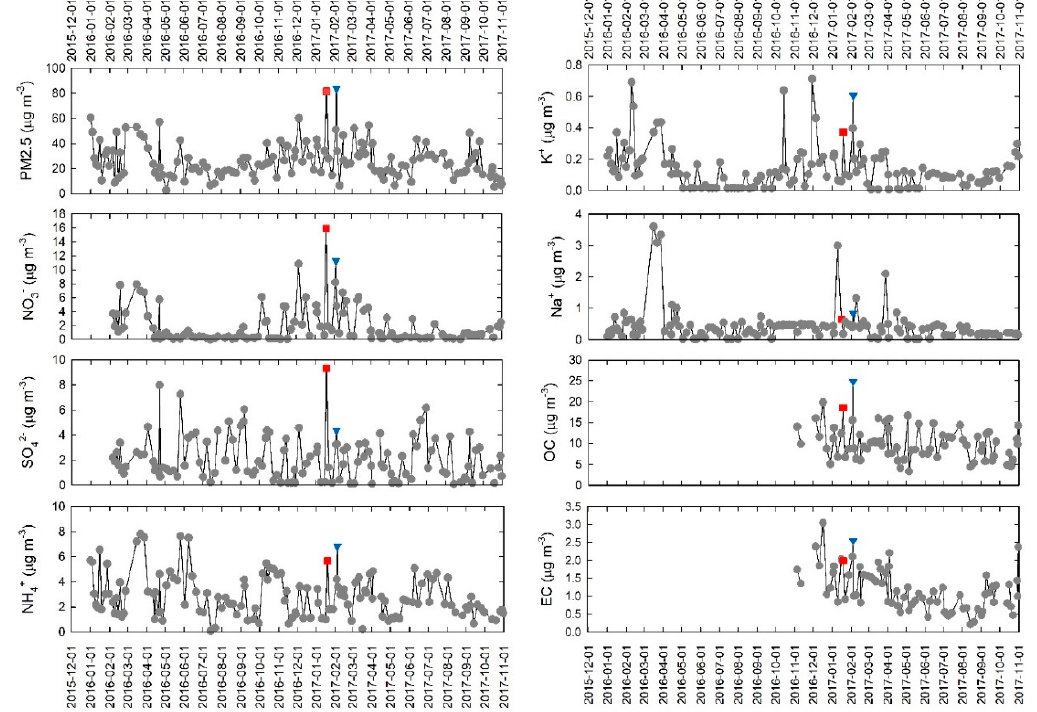
Figure 2. Daily concentrations of PM 2.5 and its components. The red and blue symbols indicate the concentrations of PM 2.5 components of the samples having the two highest PM 2.5 mass concentrations.